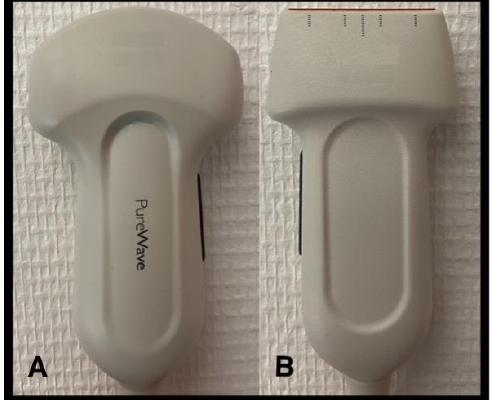
Figure 2. Probes used for lung ultrasound examination. ( A ). Convex probe, low frequency (3 – 5 Hz), preferred to explore deeper abnormalities. ( B ). Linear probe, high frequency (8 – 12 Hz), has a high superficial definition and low penetration capacity and allows better detection of superficial abnor- malities with excellent images of the pleura and lung